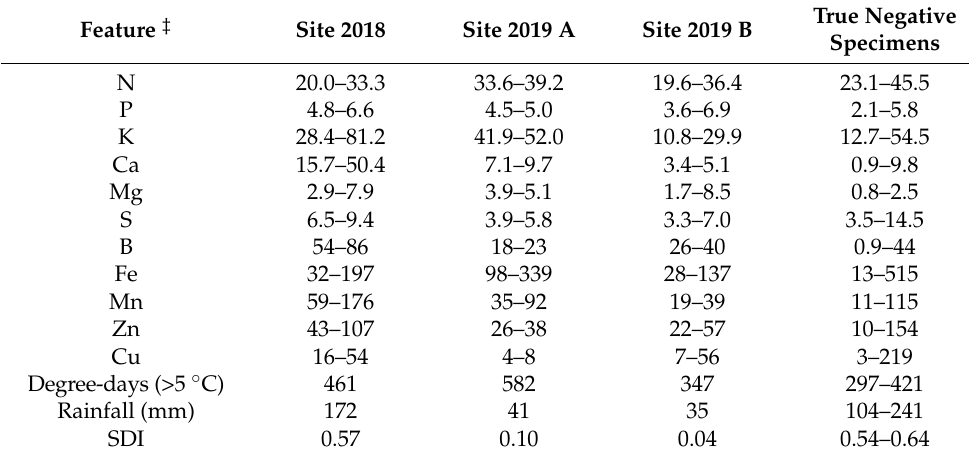
Table 4. Range of values for features to predict yields observed in 2018–2019 from the experimental dataset